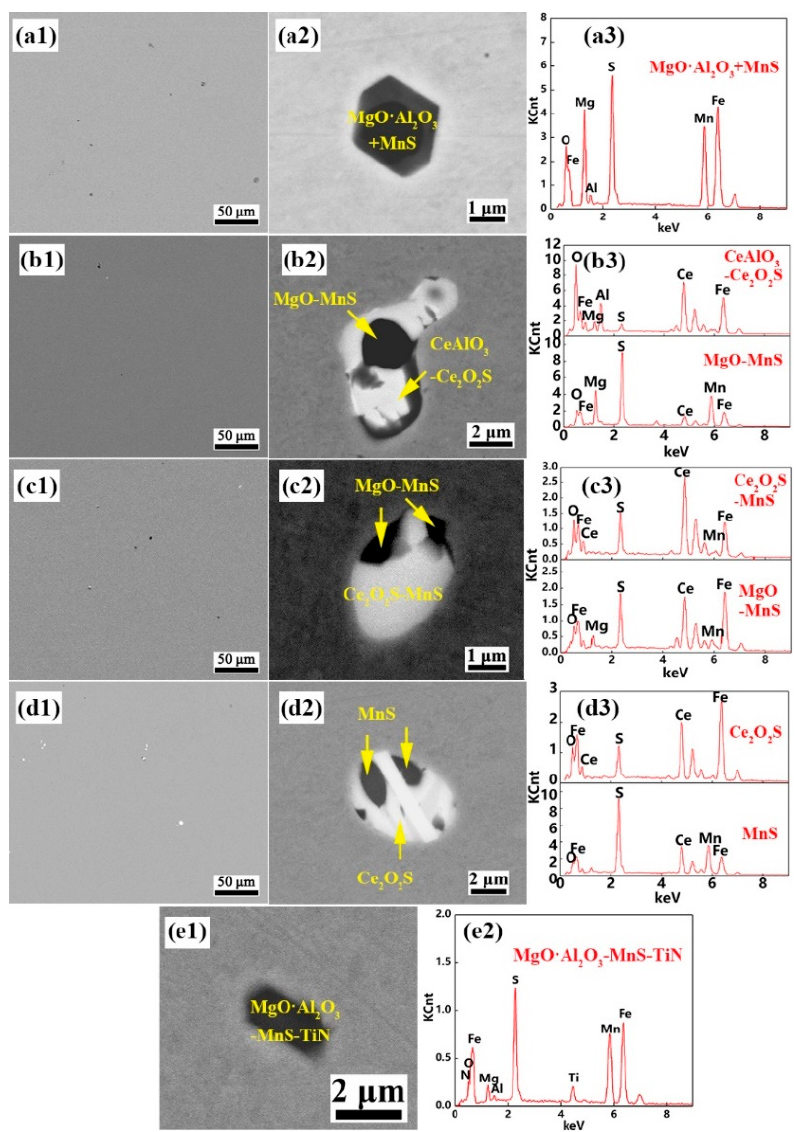
Figure 6. Typical inclusions in the as-cast samples. ( a1 – a3 ) #1 (Ce-free); ( b1 – b3 ) #2 (0.014% Ce); ( c1 – c3 ) #3 (0.024% Ce); ( d1 – d3 ) #4 (0.037% Ce) and ( e1 , e2 ) TiN-containing inclusions in the Steel #1.